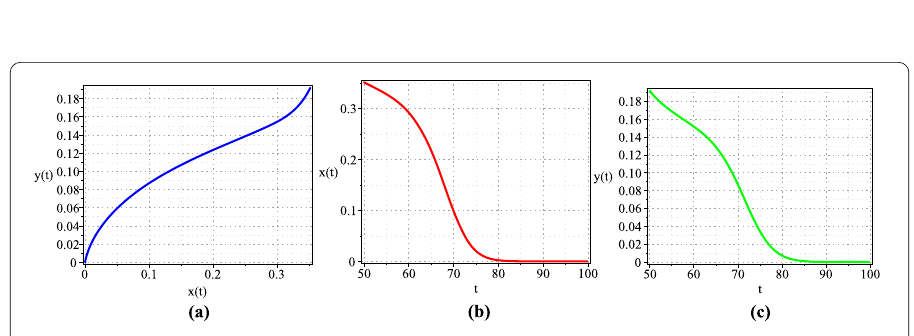
Figure 7 Numerical simulations in the case 0 < q < q ∗ . ( a ) Phase portrait of x ( t ) and y ( t ). ( b ) Time series of x ( t ). ( c ) Time series of y ( t )